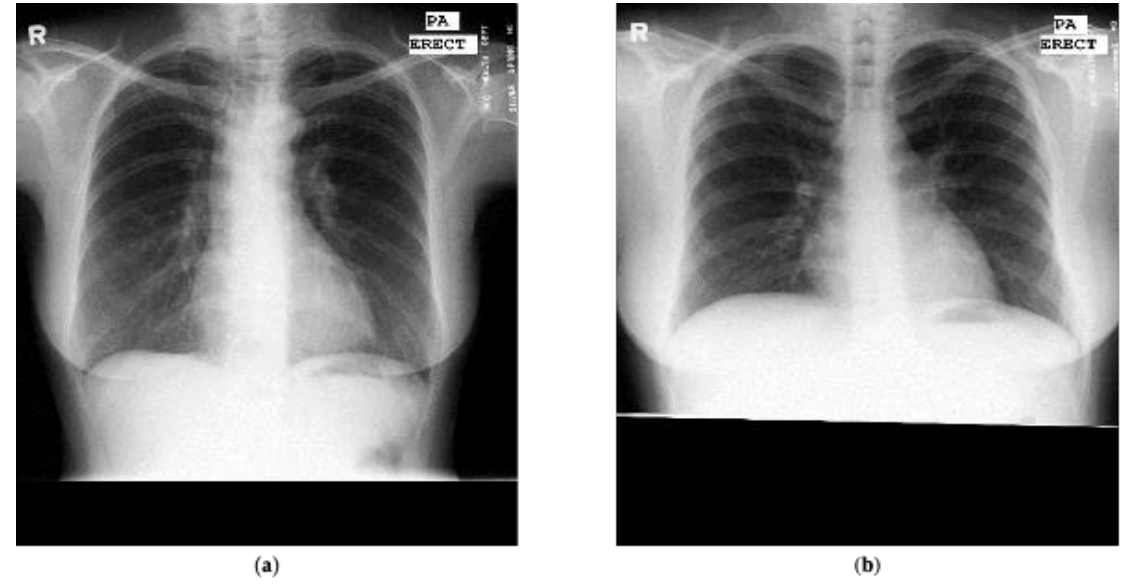
Figure 3. Chest radiograph examples from the Montgomery dataset marked by radiologists: ( a ) normal; ( b ) tuberculosis.